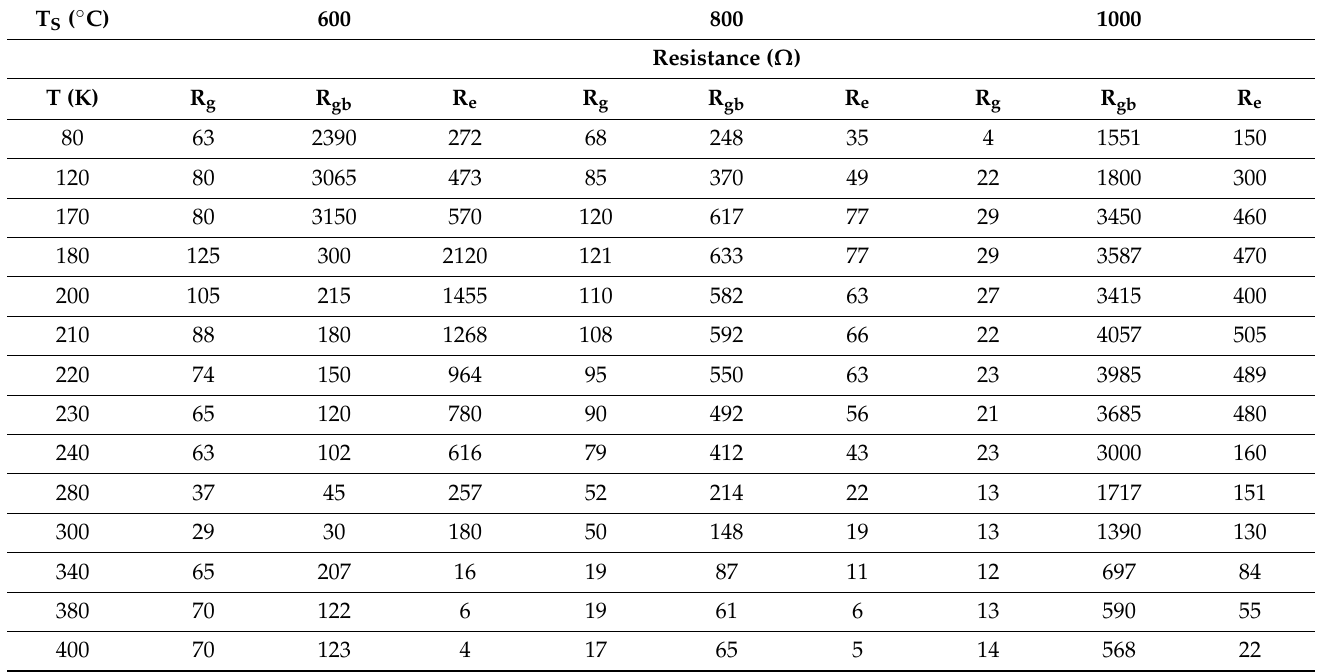
Table 2. Fitted values of grains, grain boundaries, and electrodes resistances extracted from the electrical equivalent circuit